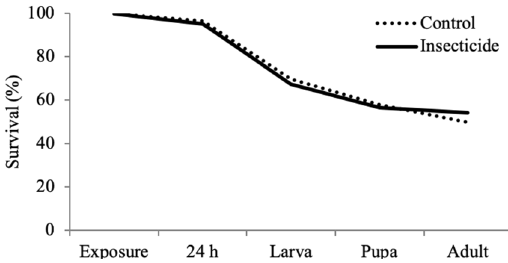
Figure 1. Survival (%) of insecticide stress exposed (solid line) and control (dashed line) of the Colorado potato beetles at different life stages. Insecticide stress exposure increases survival in the adult stage (0–10 days) when compared to control